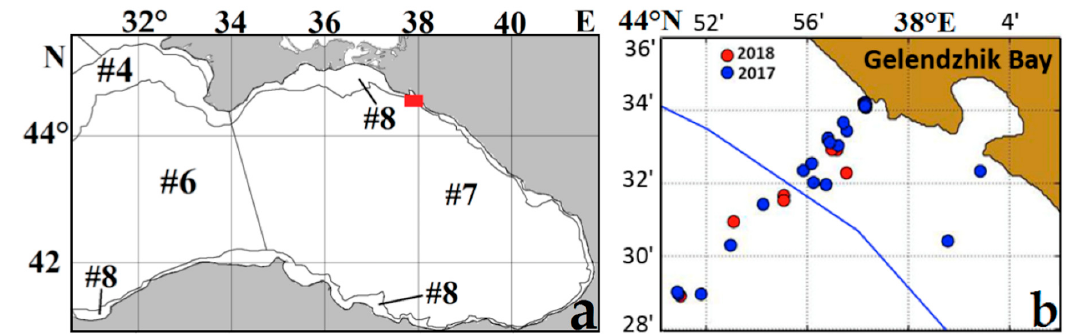
Figure 1. The study areas: ( a ) sub-regions: #4—northwestern outer shelf; #6—western open part; #7—eastern open part; #8—eastern and southern shelves [19,20]; ( b ) location of the drift stations in 2017 (blue) and 2018 (red); the blue line is the border between sub-regions #7 and #8.